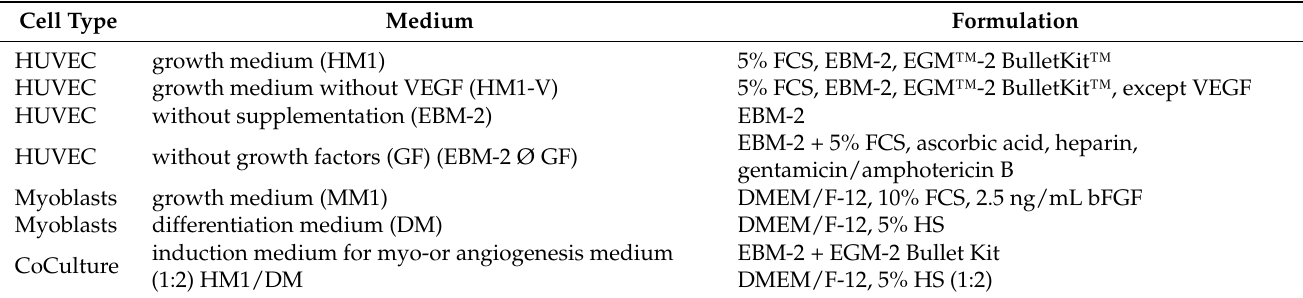
Table 1. Cell culture media and different HUVEC cell media and kits.